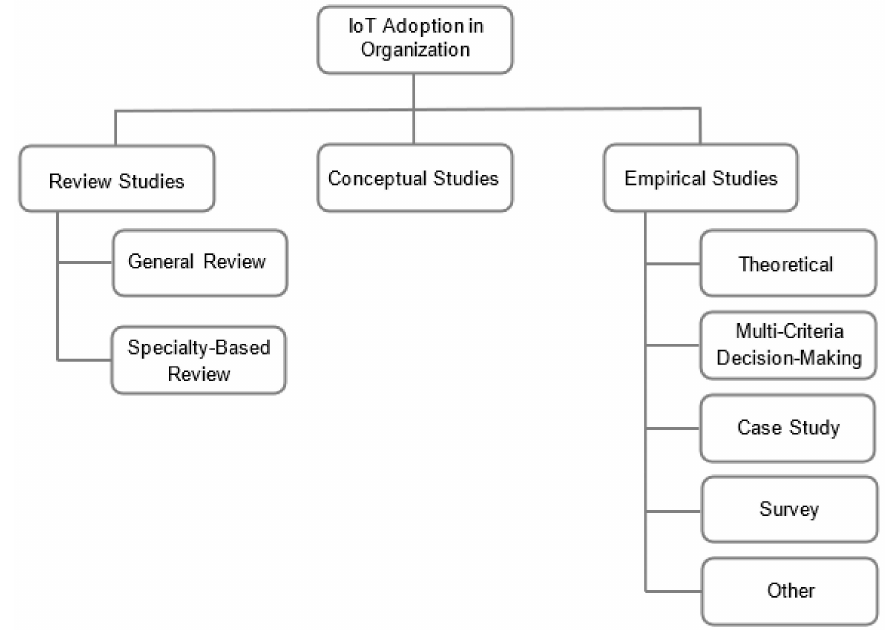
Figure 6. Taxonomy of the literature on IoT adoption in